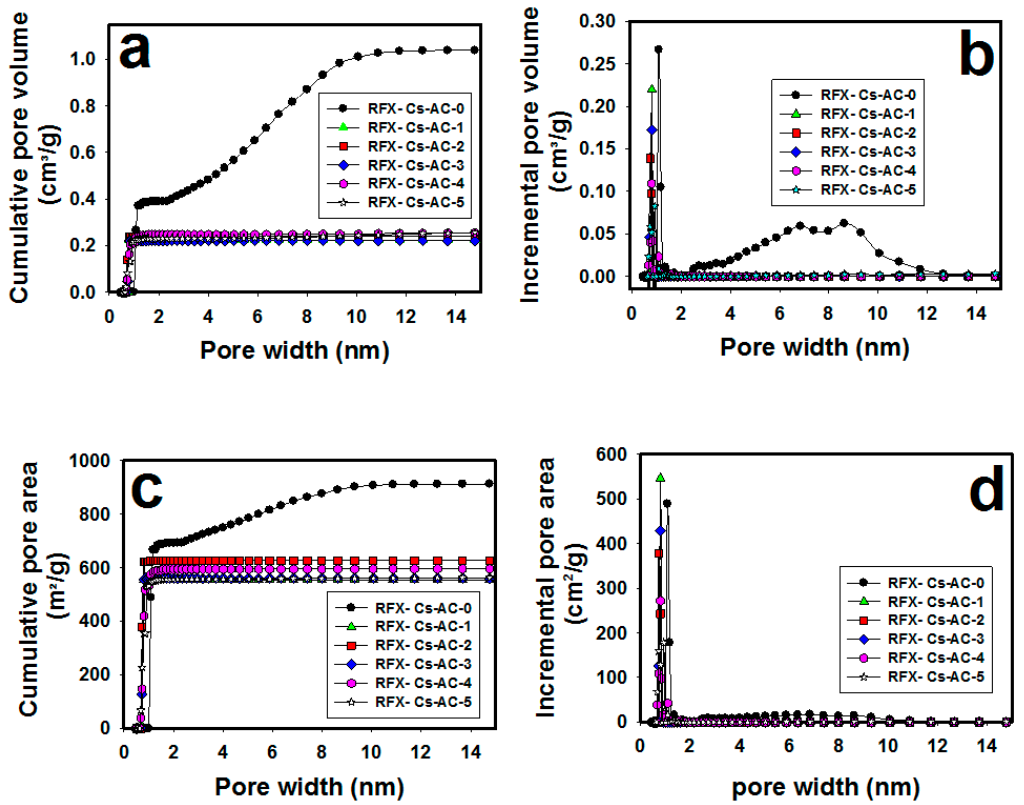
Figure 4. Relationships of ( a ) cumulative pore volume, ( b ) incremental pore volume, ( c ) cumulative pore area and ( d ) incremental pore area versus pore widths of different RFX-Cs-AC samples.